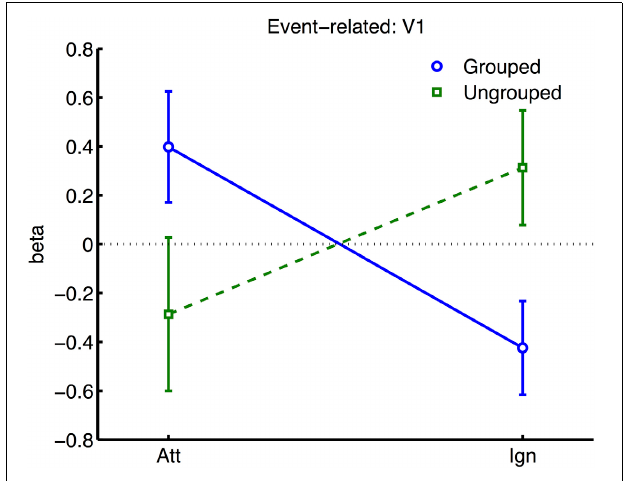
FIGURE 6 | Results from retinotopic analysis of Event-related BOLD, showing the interaction between grouping and attention, which was significant in area V1 only. Normalized beta-weights (see Methods) are plotted as a function of whether the color-change transients were on the attended or the ignored hemifield, for grouped (blue circles) vs. ungrouped stimuli (green squares). Results are averaged across areas contralateral and ipsilateral to the location of the transient.